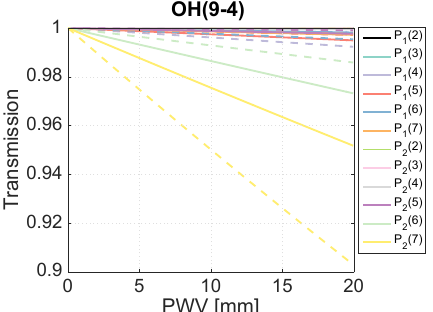
Figure 6. Water vapour transmission of the OH(9–4) P-branch lines as a function of precipitable water vapour (PWV). Solid lines rep- resent the e component of the lambda-doubled line, and the dashed lines represent the f component. The Q-branch transmissions are not represented for this band since they are all equal to 1 within 0.01% over the plotted range of